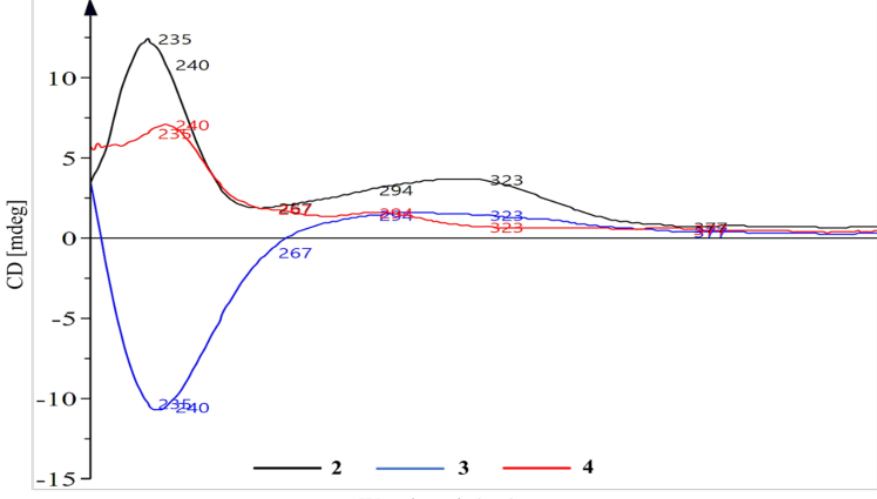
Figure 3. Major correlations, COSY (thick black line), HMBC (red arrow) and NOESY (blue arrow), observed for compounds 2 , 3 and 4 .